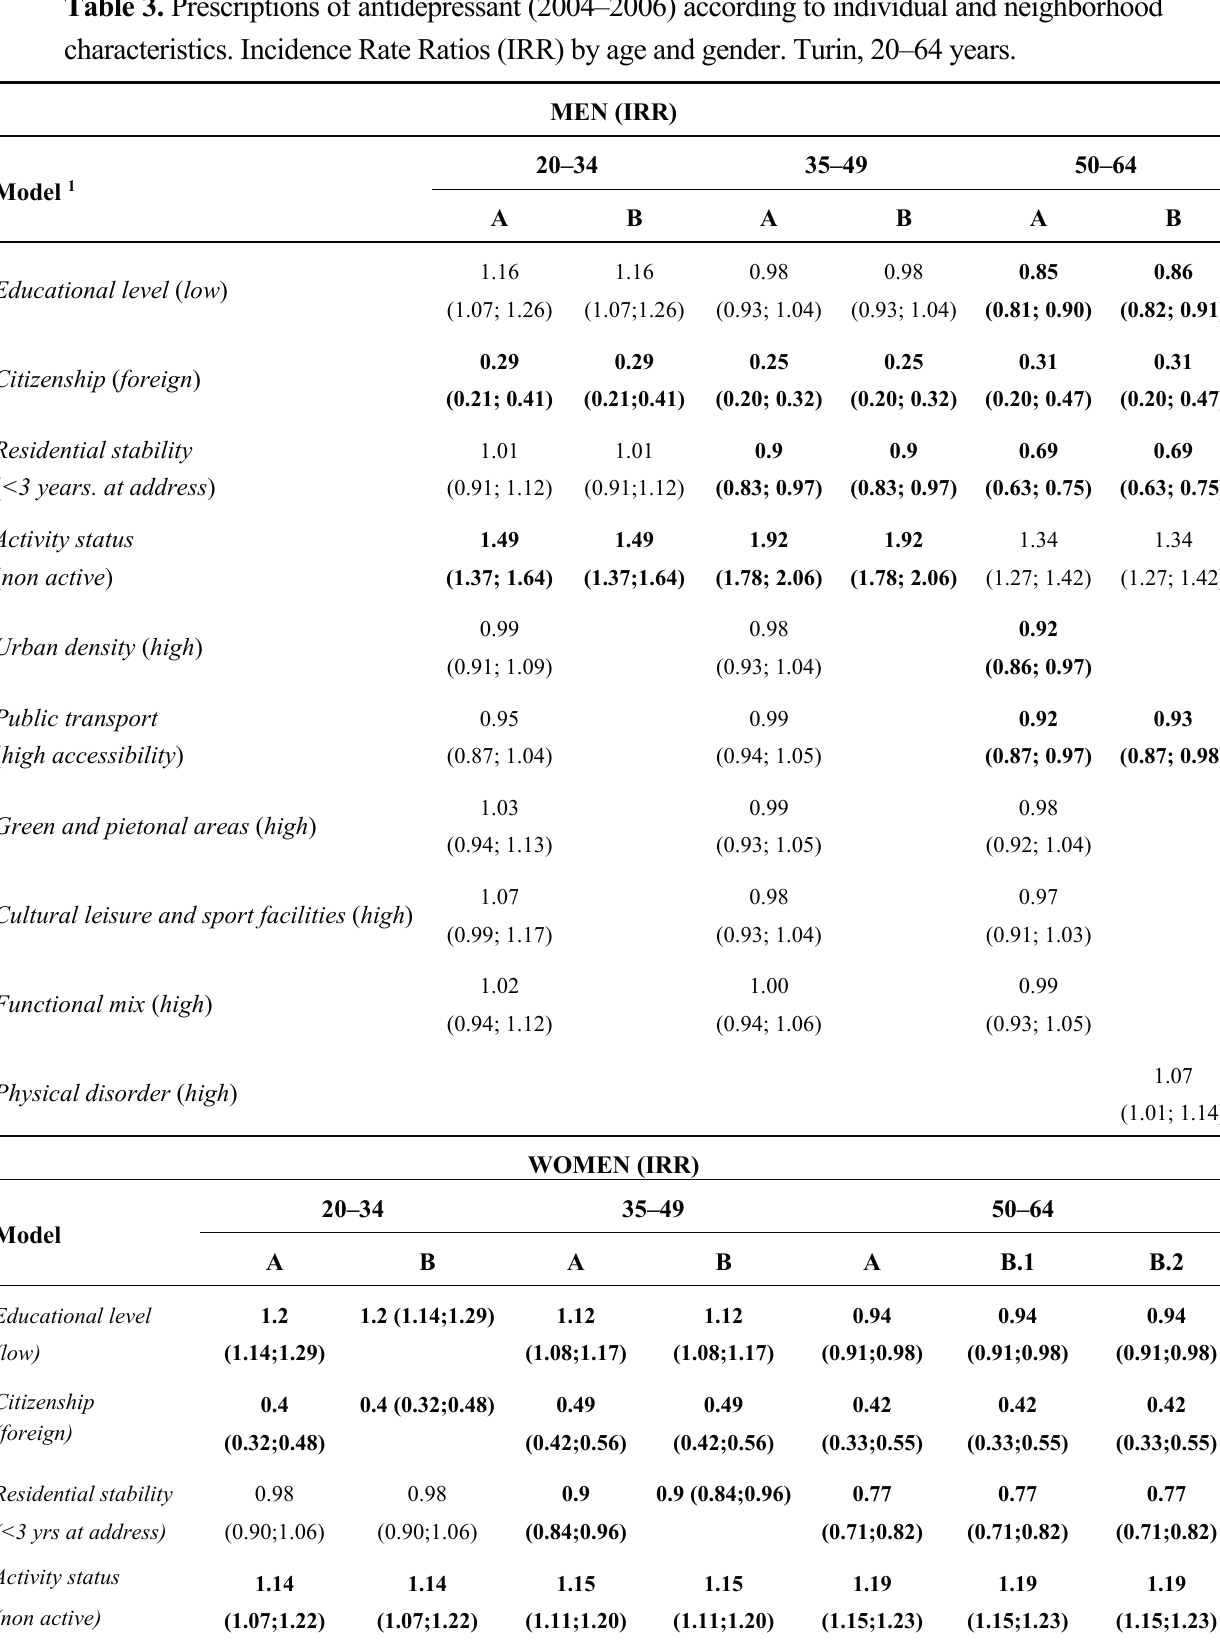
Table 3. Prescriptions of antidepressant (2004–2006) according to individual and neighborhood characteristics. Incidence Rate Ratios (IRR) by age and gender. Turin, 20–64